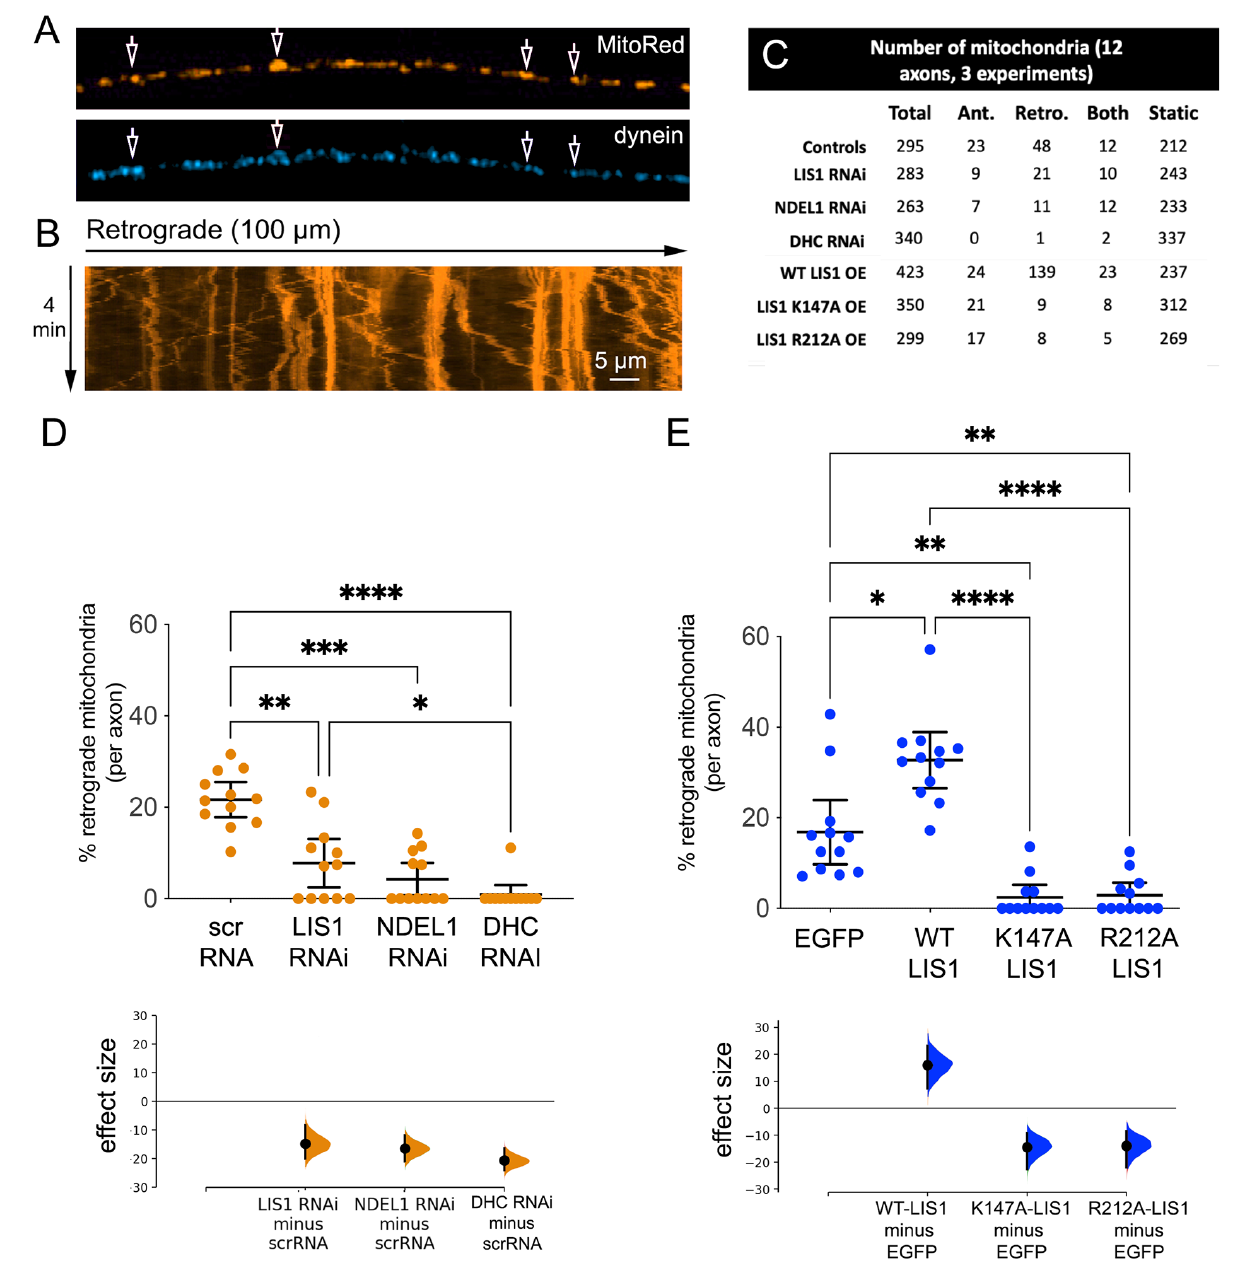
FIGURE 2 | Both LIS1 and NDEL1 impact the percentage of axonal mitochondria moving retrogradely. (A) Axonal dynein motors stained with a dynein intermediate chain antibody (bottom panel) colocalize with axonal mitochondria (labeled with MitoTracker Red, top panel) in cultured adult rat DRG neurons. Arrows point to specific organelles to better visualize colocalization. (B) A typical kymograph generated from a time-lapse movie of MitoTracker Red-labeled mitochondria in a living axon. (C) The table shows the total numbers of mitochondria from 12 axons (in three cultures prepared from different rats) and the numbers that moved anterogradely (Ant.) retrogradely (Retro.), moved both directions (both), or remained static during the recording interval for three different KDs (LIS1, NDEL1, and DHC RNAi) and three different LIS1 constructs (WT LIS1, K147A-LIS1, 212A-LIS1). Scrambled RNA and EGFP only controls were combined since numbers were similar. (D) The percentage of mitochondria that only moved retrogradely in axons exposed to the indicated RNAi constructs is plotted on the upper axes. Each point corresponds to a single axon (of 12 axons measured from three independent cultures from three different rats). Error bars show the mean ± CI. The effect size is visualized on the lower axes, in which mean differences from a shared control are plotted as bootstrap sampling distributions. The mean difference is depicted as a dot and 95% confidence interval is indicated by the ends of the vertical error bars. (E) Similar plots are shown for axons overexpressing LIS1 constructs. For all data, significance was determined by Kruskal-Wallis nonparametric ANOVA with multiple comparisons using the two-stage linear step-up procedure of Benjamini, Kreiger, and Yekutieli to control for false discovery rate. ∗∗∗∗ p < 0.0001; ∗∗∗ p < 0.001; ∗∗ p < 0.01; ∗ p < 0.05.